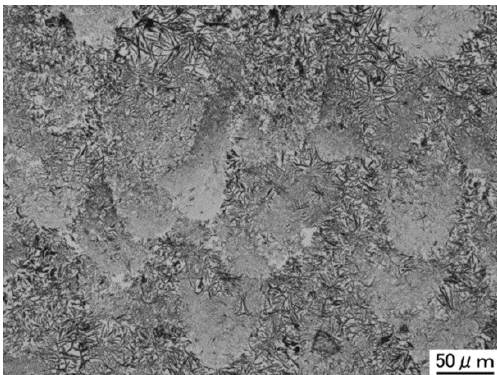
Figure 6. Enlarged OM image of a vertical cross section of the optimally processed material with Rot scanning pattern.